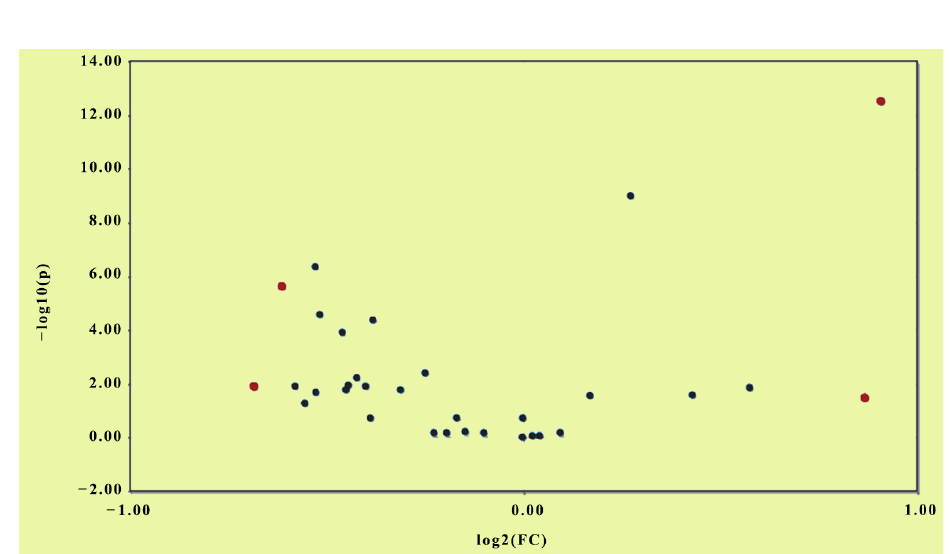
Figure 1. Volcano plot of variables between AD and control groups (False Discovery Rate (FDR) < 0.05, fold change (FC) > 1.5). Red dots indicate significantly di ff erent variables in relation to